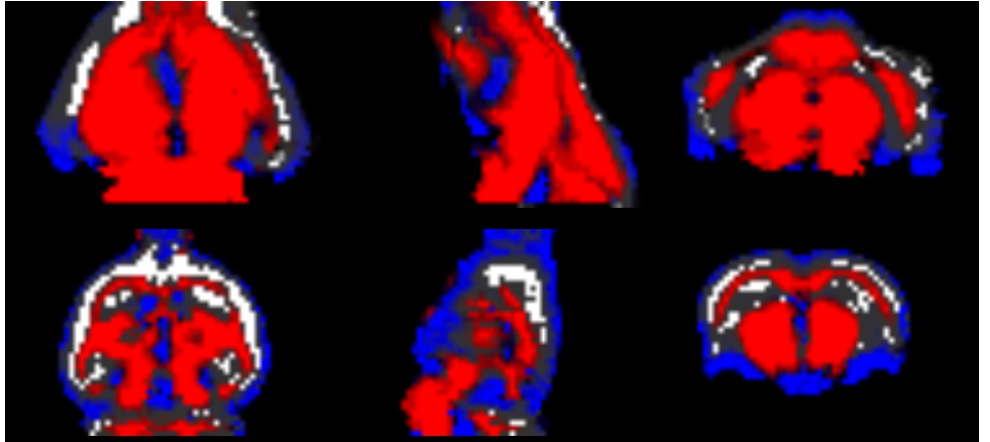
Figure 10. Semantic masks built with the SPM12 software. The semantic mask in the first row was built using a scan generated by the α -WGAN_ADNI model, and the semantic mask in the second row was built using a scan generated by the α -WGANSigmaRat2 model. The blue colour is the CSF, the red colour is the WM, and the grey scale is the